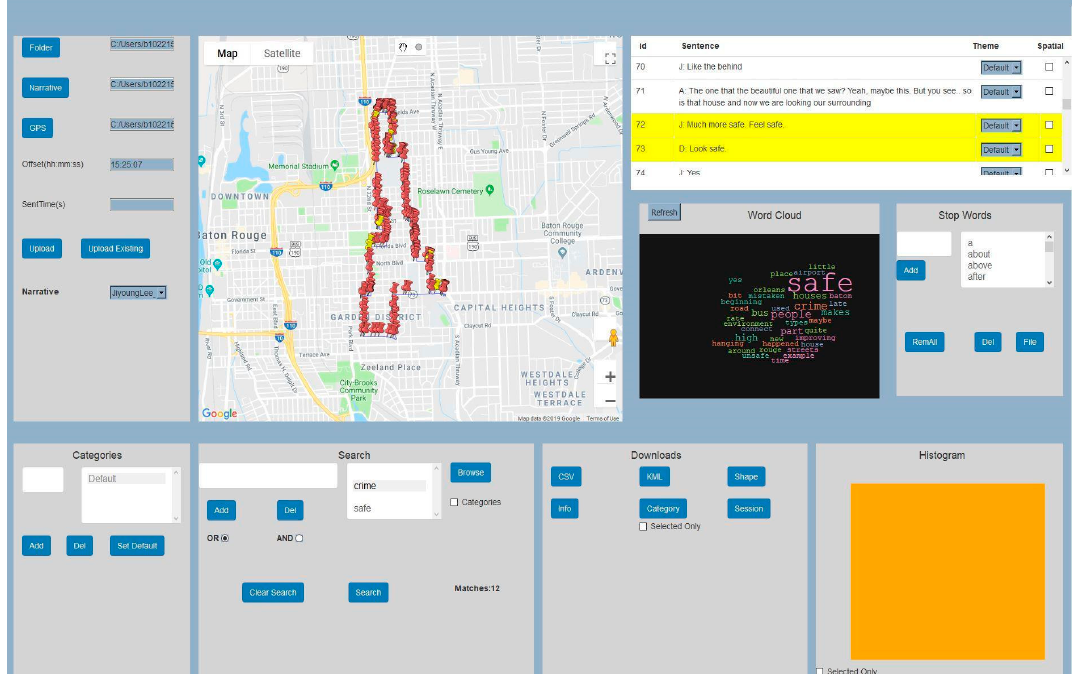
Figure 5. The interface of the software Wordmapper: Reading the input data (upper left); showing the mapped route with pins (upper middle); displaying individual sentences, a word cloud, and stop words (upper right); additional filters, queries, and histogram display (bottom).